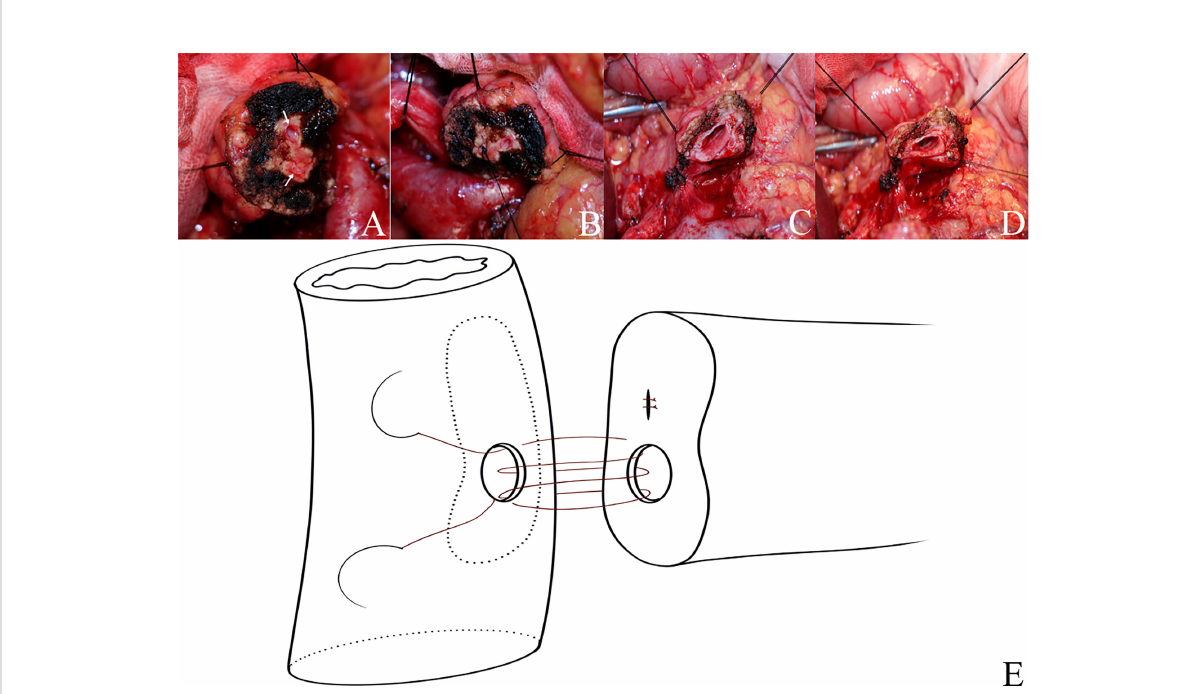
FIGURE 7 Suture closure method and double-layer continuous suturing pancreaticojejunostomy. (A – D) Suture closure method (suture and ligate the small pancreatic duct with silk thread). (E) The large pancreatic duct was anastomosed with the small intestine by double-layer continuous suturing pancreaticojejunostomy with 5-0 and 3-0 Prolene,